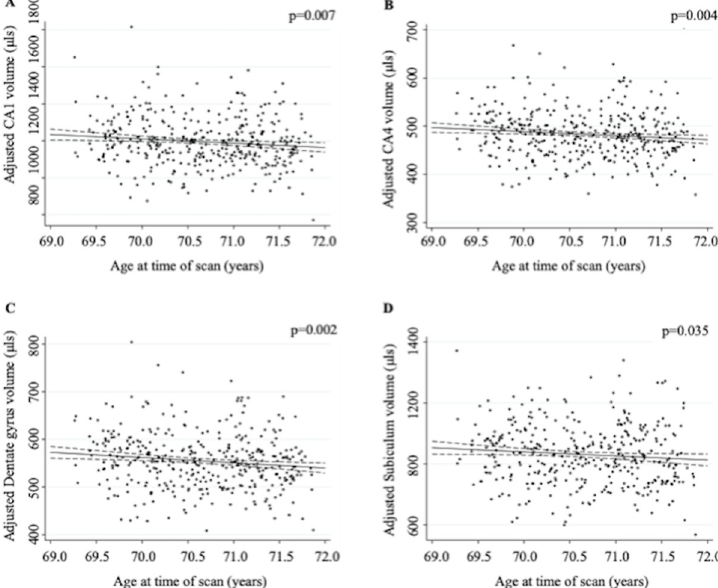
Fig 1. Age is associated with lower CA1 (panel A), CA4 (panel B), dentate gyrus (panel C) and subiculum (panel D) volume in cognitively normal older adults following adjustment for sex, TIV, amyloid status and WMHV. Dashed lines represent 95% confidence intervals, TIV = total intracranial volume; WMHV = white matter hyperintensity